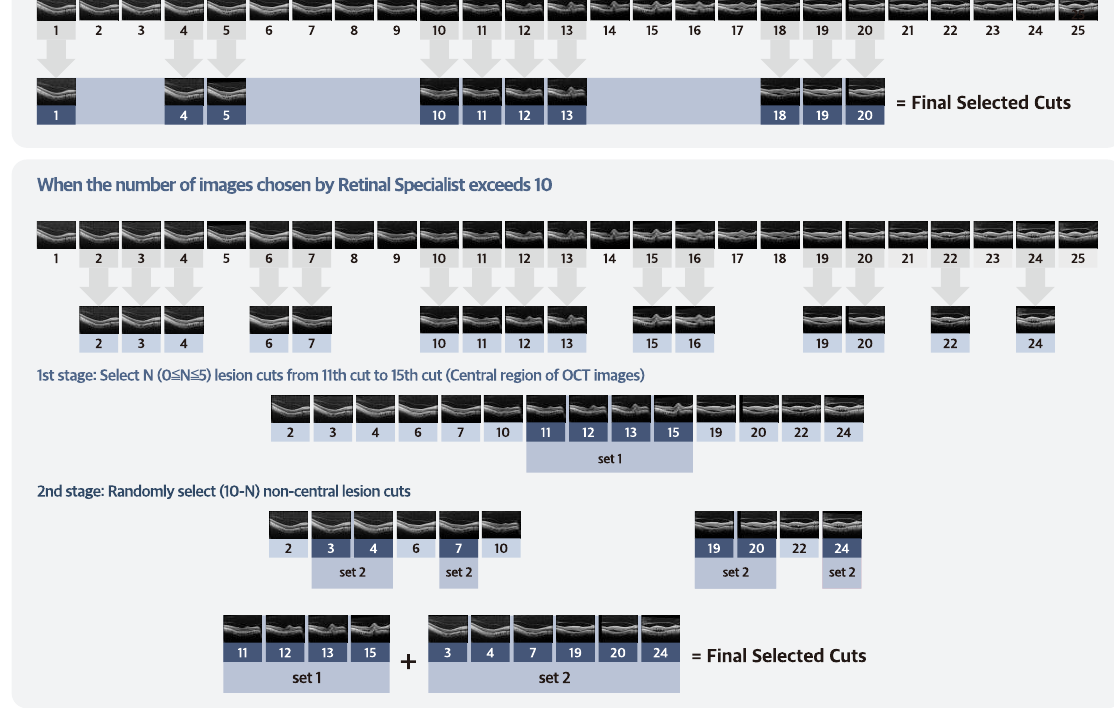
Figure 1. The extraction process of lesion cuts from 25 SD–OCT scan images. The retina specialists initially extracted lesion cuts from each patient’s SD–OCT images. If the extracted lesion cuts from a patient were ≤ 10, all lesion cuts were used as SD–OCT datasets. However, if the total number of lesions cut was >10, we selected N (that is, 0 ≤ N ≤ 5) lesion cuts between the 11th–15th central regions. Finally, we randomly selected 10–N lesion cuts from non–centered regions (1st–10th and 16th–25th). In this study, we selected about 10 images per patient.